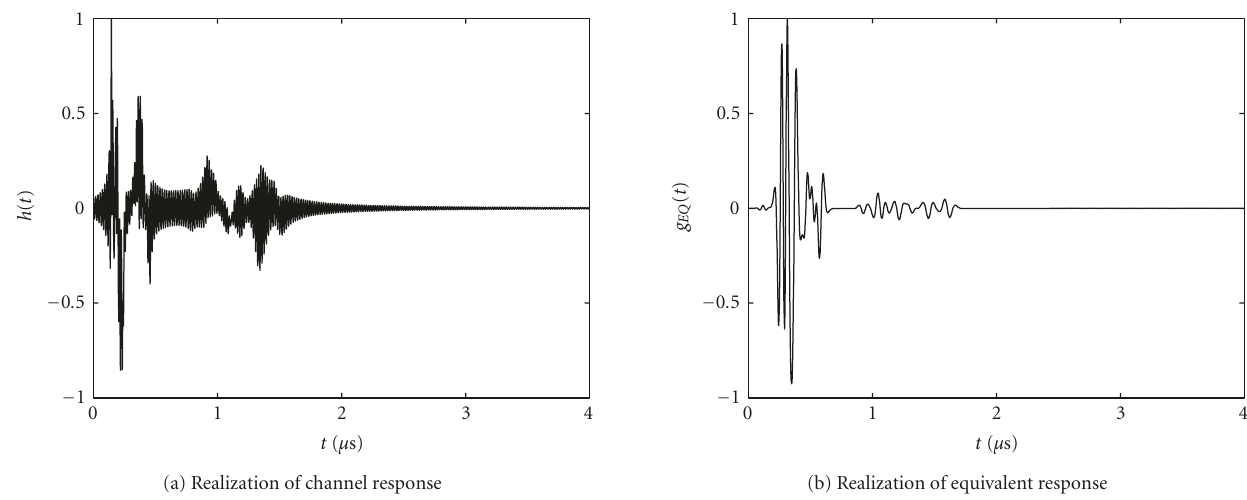
Figure 5: Examples of statistical channel realization (a) and equivalent impulse response